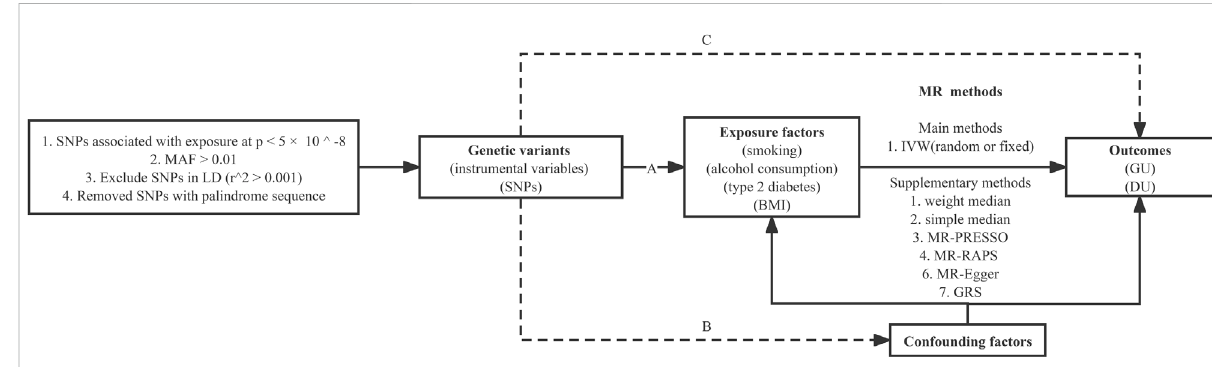
FIGURE 1 Study design overview and assumptions of the Mendelian randomization framework. IVW, inverse-variance weighted; LD, linkage disequilibrium; SNPs, single-nucleotide polymorphisms. MR-PRESSO, Mendelian randomization pleiotropy residual sum and outlier; MR-RAPS, Mendelian randomization robust-adjusted pro fi le score. It is shown that (A) the genetic variants proposed as instrumental variables should be robustlyassociatedwiththeriskfactorofinterest; (B) theusedgeneticvariantsshouldnotbeassociatedwithpotentialconfounders;and (C) the selected genetic variants should affect the risk of the outcome merely through the risk factor, not via alternative